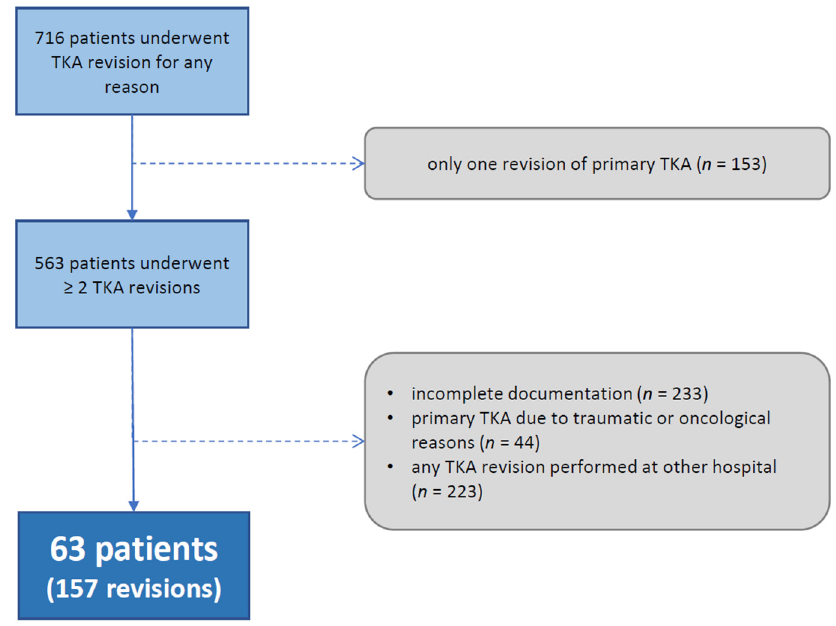
Figure 1. Patient enrollment. TKA = total knee replacement.